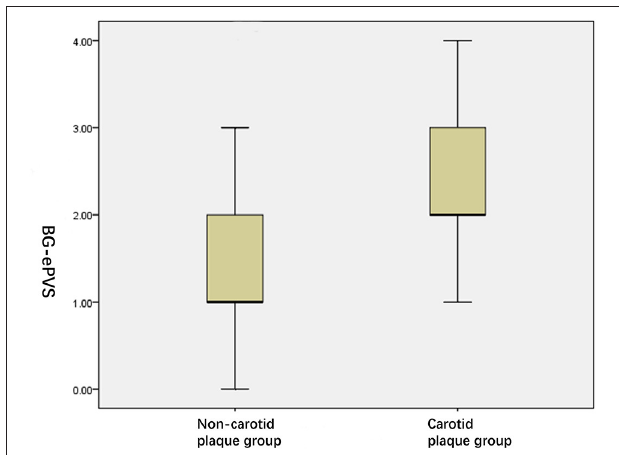
FIGURE 5 | High grade BG-ePVS in two groups.